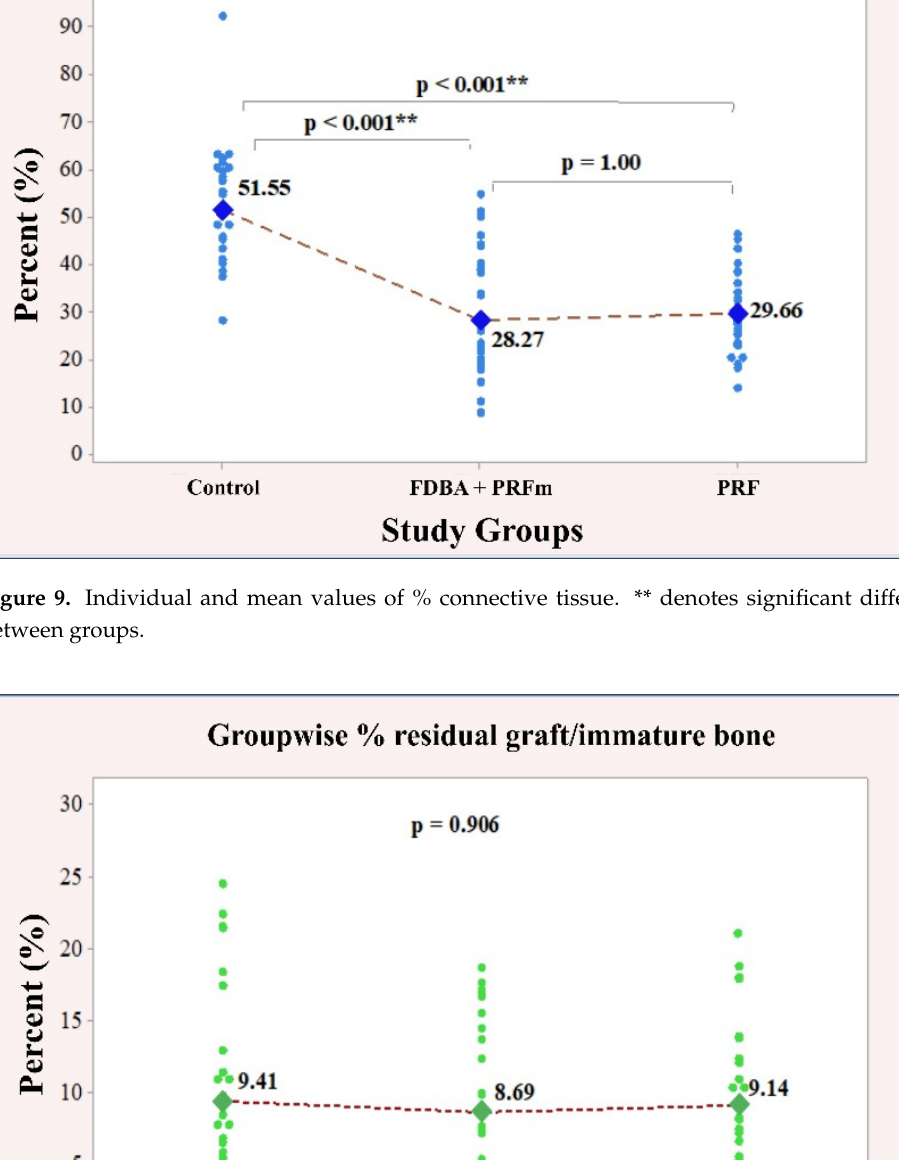
Figure 8 . Individual and mean arithmetic values of % vital bone. ** denotes significant difference between groups.